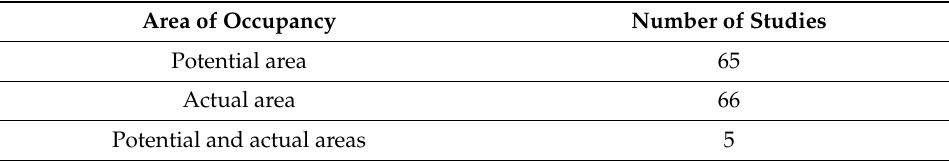
Table 3. Number of studies reviewed per type of occupancy area.